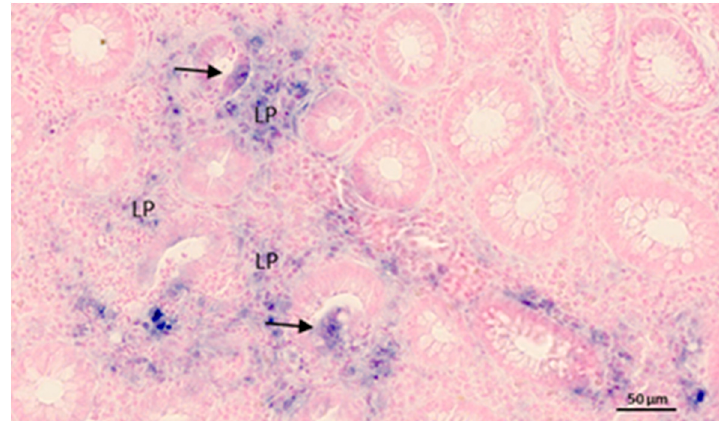
Figure 1. MiR-21 in situ hybridization in ulcerative colitis. The example shows the inflamed colon mucosa with transversally cut crypts and the lamina propria (indicated by LP). The miR-21 ISH signal is represented by the blue stain and is seen in inflammatory cells located in the lamina propria in and some of the epithelial cells (arrows) in some collapsed crypts. Nuclear Fast Red was used in counterstaining.